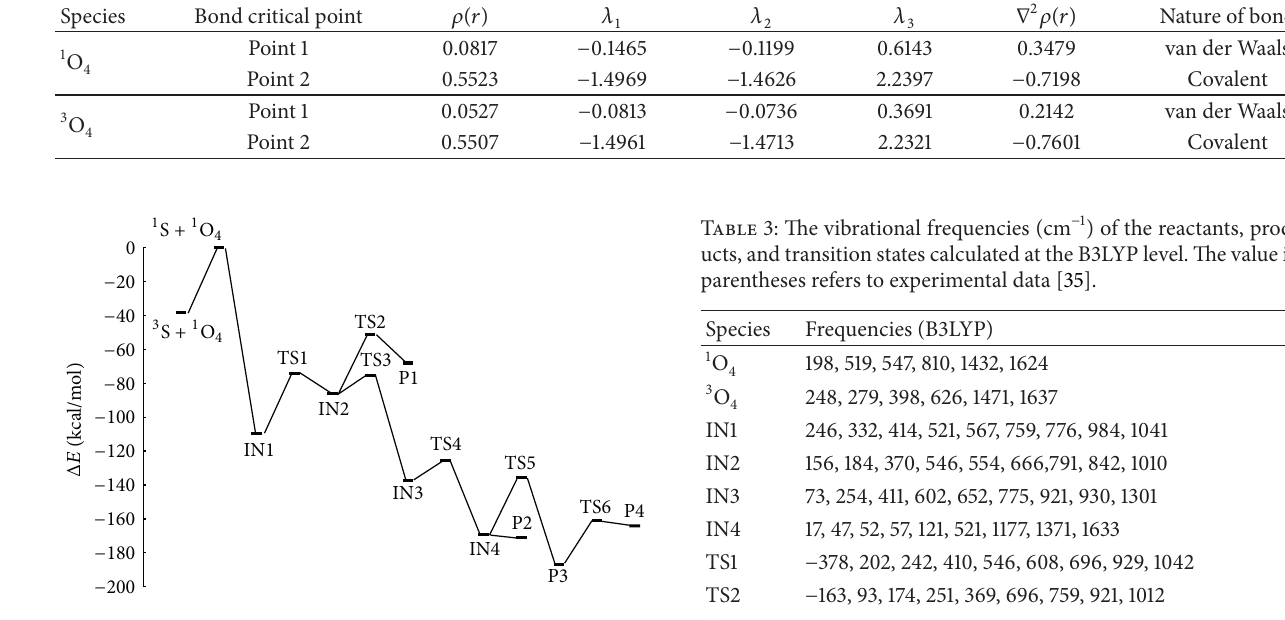
Table 2: Topological analyses of O Species